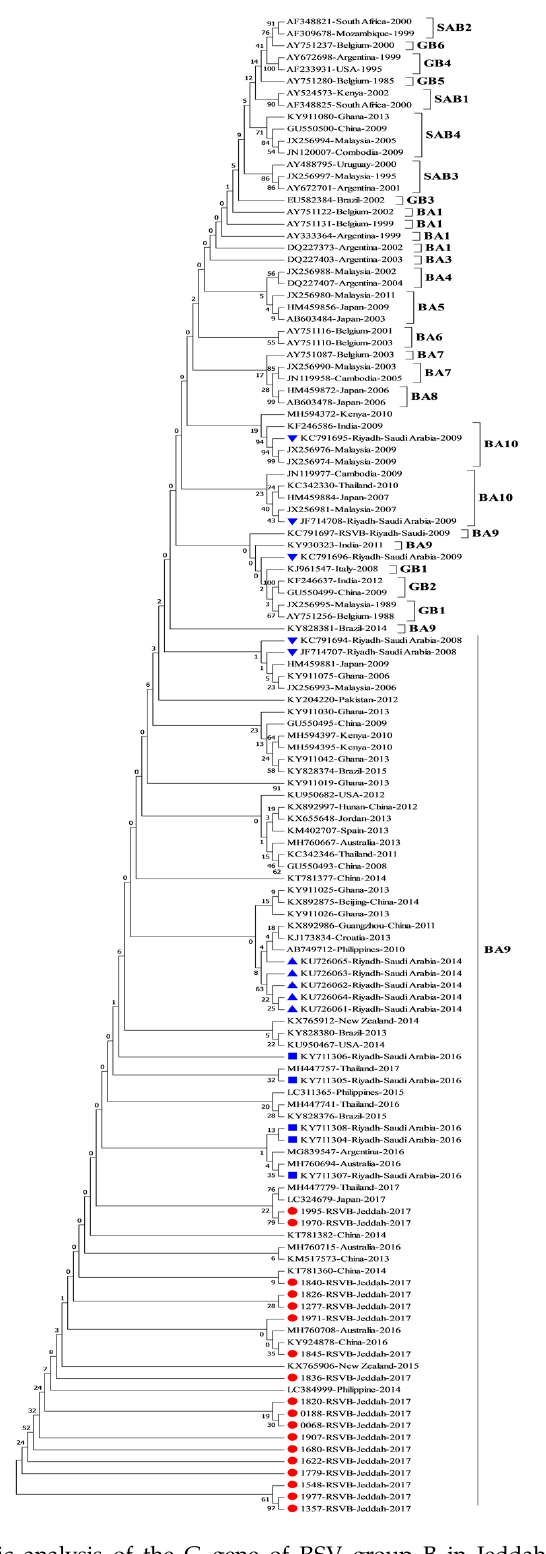
Figure 3. Phylogenetic analysis of the G gene of RSV group B in Jeddah, Saudi Arabia (2017). Saudi sequences in this study are labeled with a red square and reference strains are labeled as accession number-country-year of isolation; Saudi reference strains isolated in 2014 are labeled with a blue diamond and those isolated in 2014–2016 are labeled with a blue circle; the Riyadh samples isolated in 2008–2009 are labeled with an inverted triangle and Taif samples are labelled with a blue triangle. Phylogenetic trees were constructed using the neighbor-joining method after being aligned with CLUSTALW using MEGA